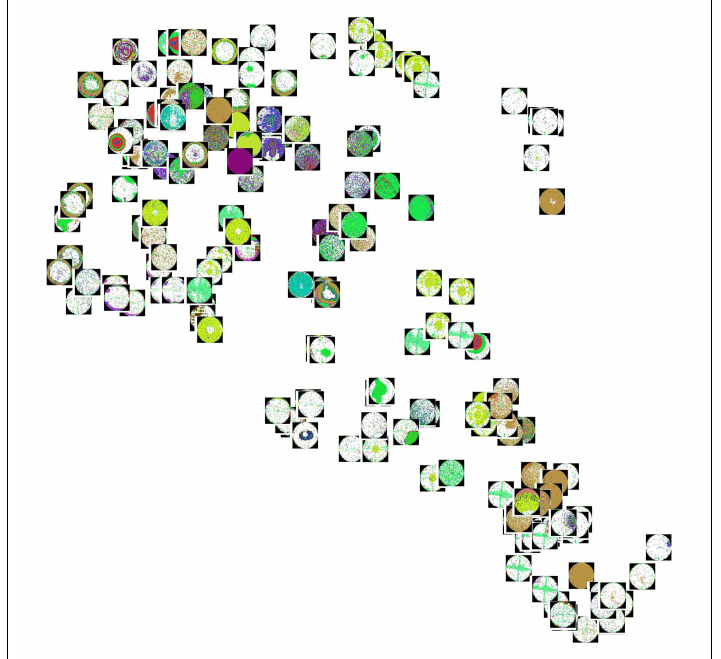
Figure 17. Visualizing bad wafers based on t-SNE and random